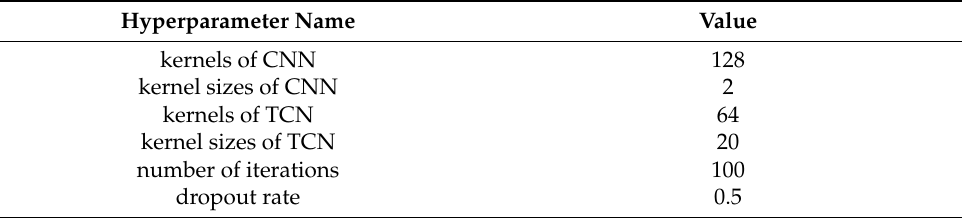
Table 4. The hyperparameters and value of the